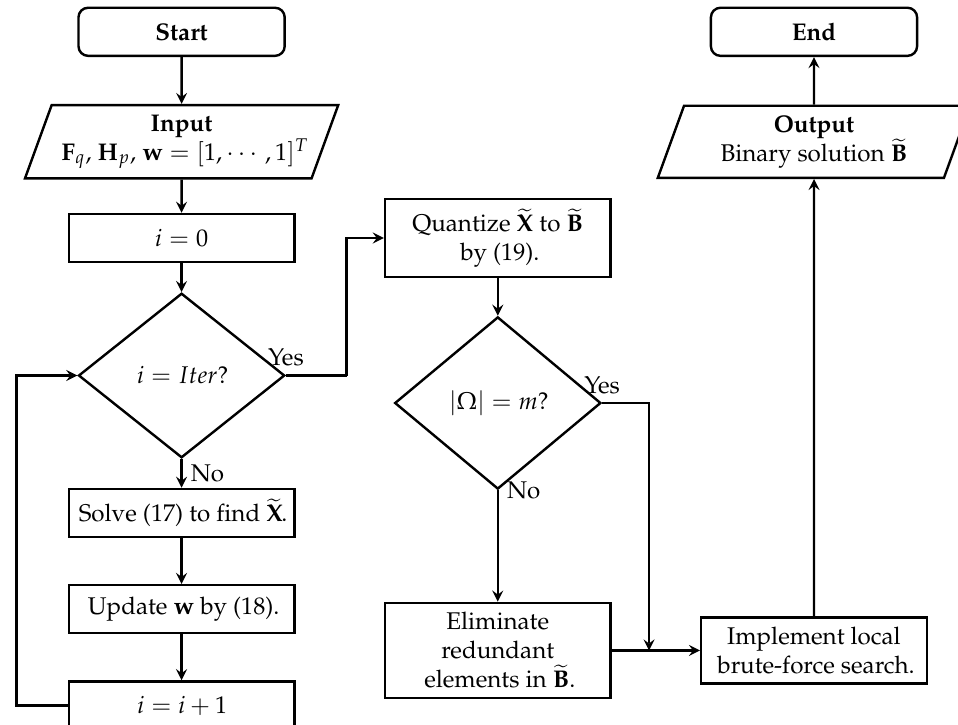
Figure 1. The optimization process for obtaining the Kronecker-product-based frame. In this process, eliminating redundant elements in B and implementing local brute-force search are carried out by Steps 5 and 6 of Algorithm 2 in [41], respectively.